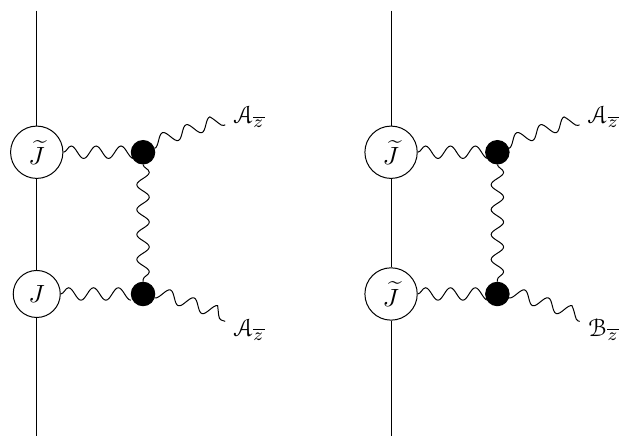
Figure 5 . These diagrams quantum correct the chiral algebra for holomorphic BF